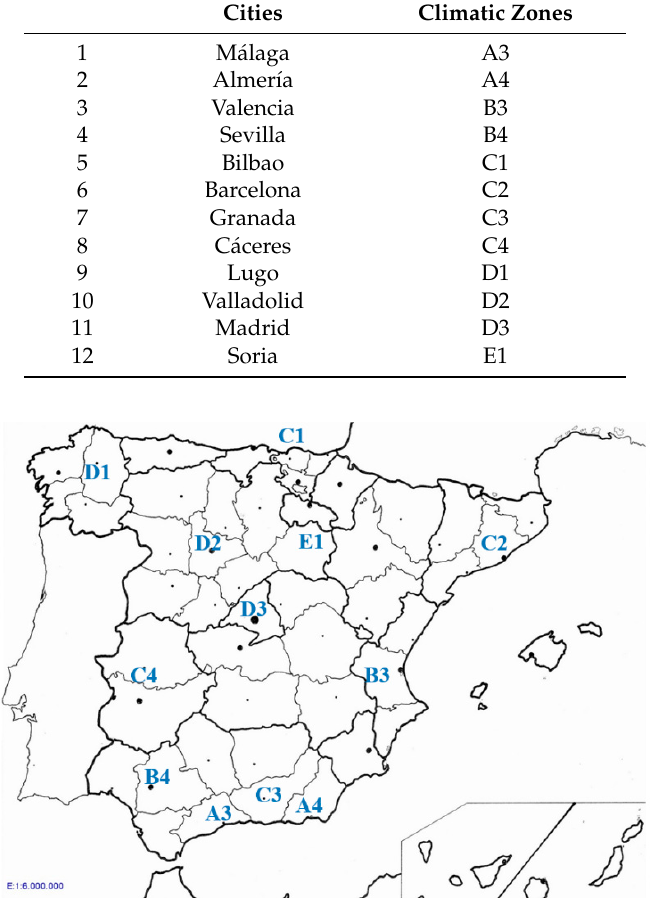
Table 2. Cities of the case studies.